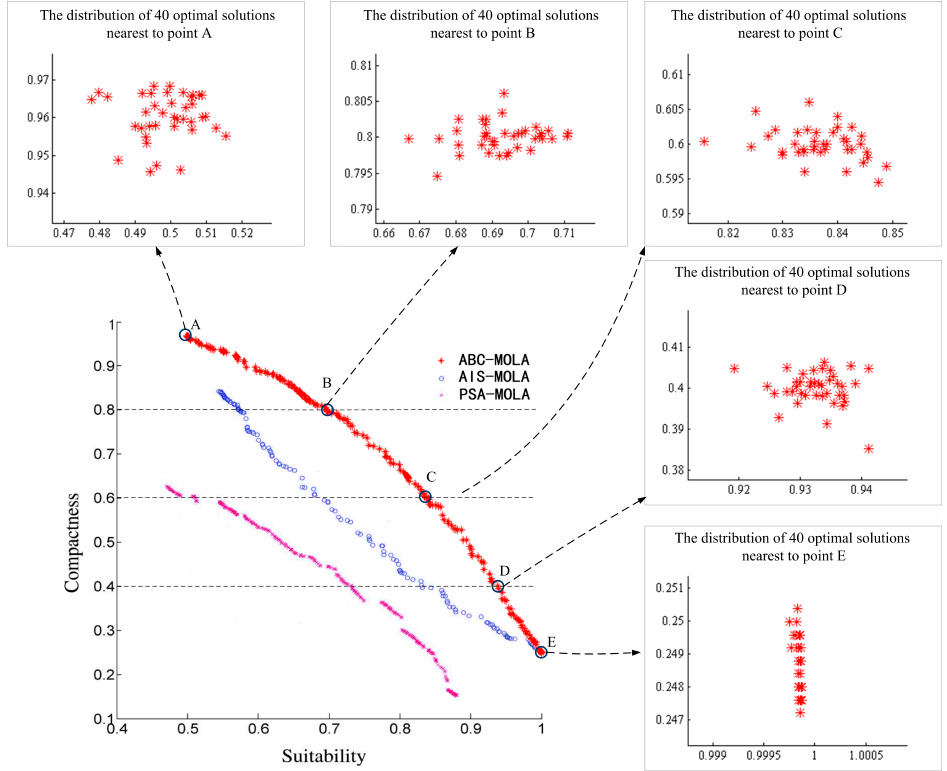
Figure 7. Pareto fronts of generated by ABC-MOLA, artificial immune system (AIS)-MOLA and Pareto simulated annealing (PSA)-MOLA. The latter two algorithms’ Pareto fronts are adapted from [28]. Table 4. Statistics of five sets of solutions labeled in the Pareto front of Pareto-ABC algorithms (labeled in Figure 7) based on 40 experiment results.